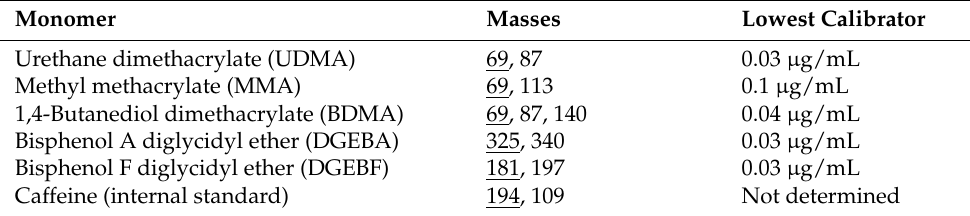
Table 1. Characterization of monomers in GC-MS; the quantification masses are underlined. Monomer Masses Lowest Calibrator Urethane dimethacrylate (UDMA) 69, 87 0.03 µ g/mL Methyl methacrylate (MMA) 69, 113 0.1 µ g/mL 1,4-Butanediol dimethacrylate (BDMA) 69, 87, 140 0.04 µ g/mL Bisphenol A diglycidyl ether (DGEBA) 325, 340 0.03 µ g/mL Bisphenol F diglycidyl ether (DGEBF) 181, 197 0.03 µ g/mL Caffeine (internal standard) 194, 109 Not